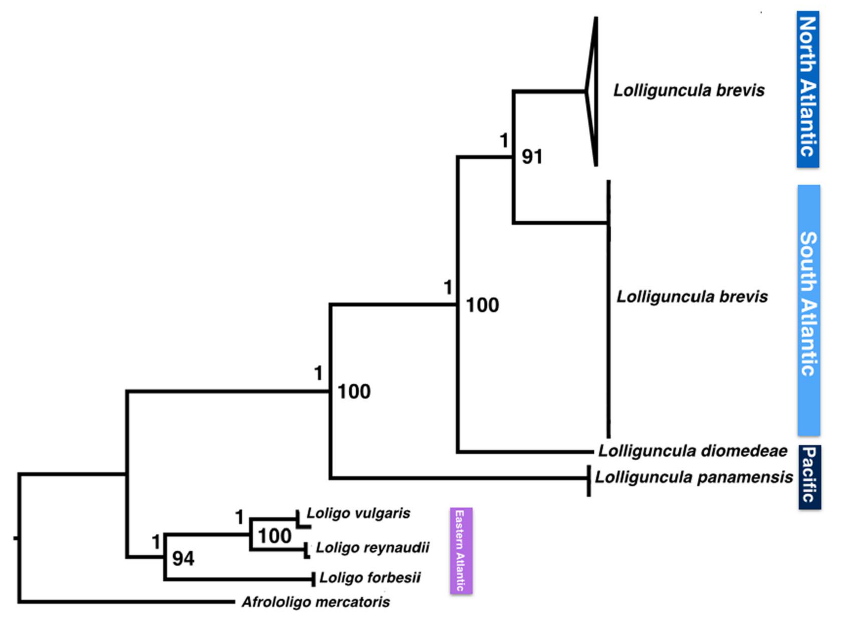
Figure 1. Maximum Likelihood Phylogenetic tree of the genus Lolliguncula . Topology based on the concatened datasets (16S + COI + Rhod). Bayesian credibility support and Bootstrap values are shown above and in front of the nodes, respectively.